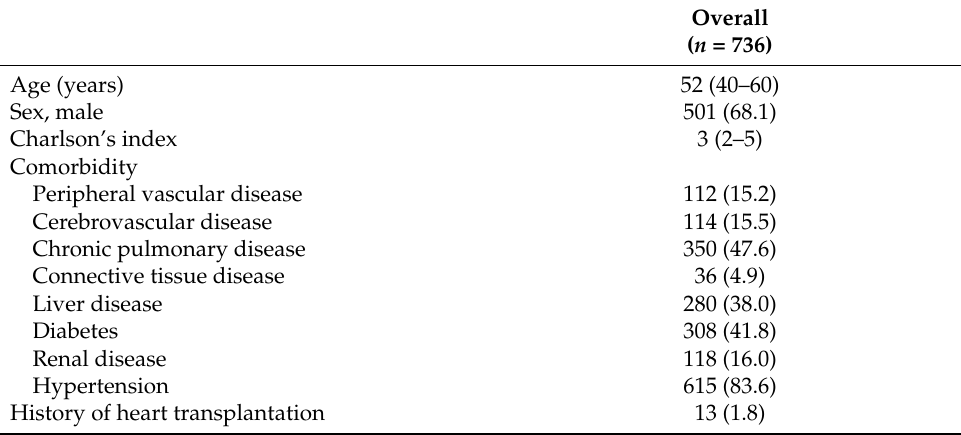
Table 1. Characteristics of the patients that underwent heart